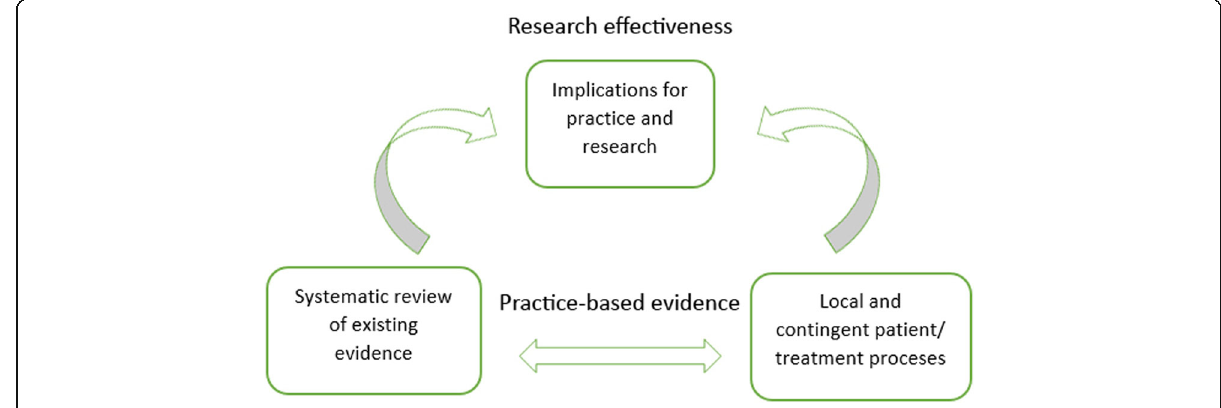
Fig. 3 Typical knowledge generation process in practice-based evidence